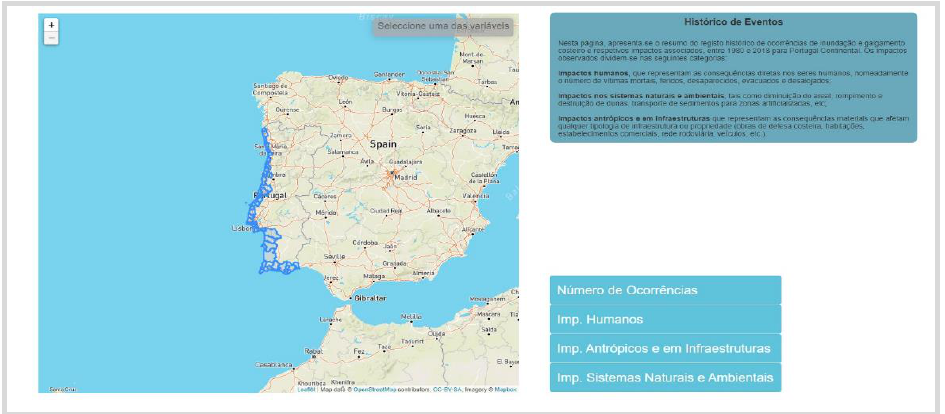
Figure 7. Default view of the Historical Data of Coastal Flooding Occurrences page, with no county or variable chosen.